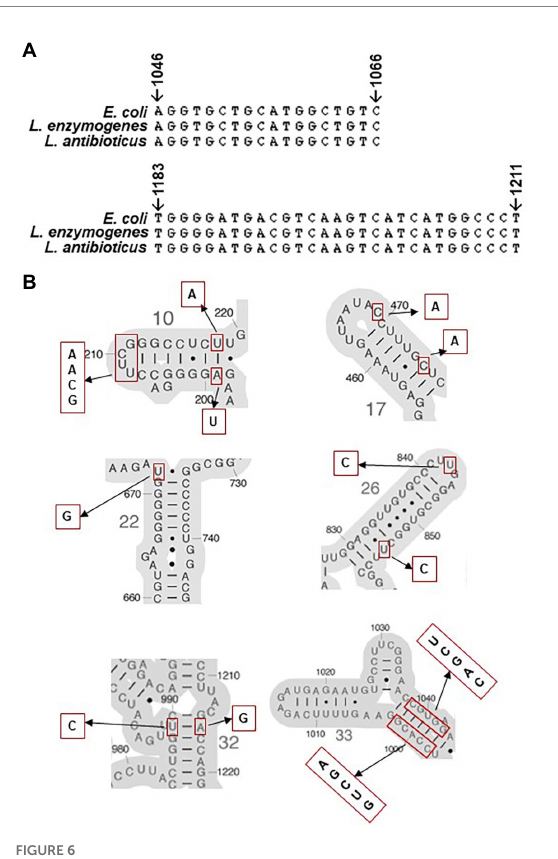
FIGURE 6 Comparison of 16S rRNA. (A) Multiple sequence alignment of hot spots in 16S rRNA genes from Escherichia coli , Lysobacter enzymogenes , and Lysobacter antibioticus with known spectinomycin resistance mutations. (B) Secondary structures of E. coli 16S rRNA around point mutation sites identified between L. enzymogenes and L. antibioticus . Putative resistance nucleotides to spectinomycin are marked using red rectangular and the corresponding sequences in LeC3 are shown on the